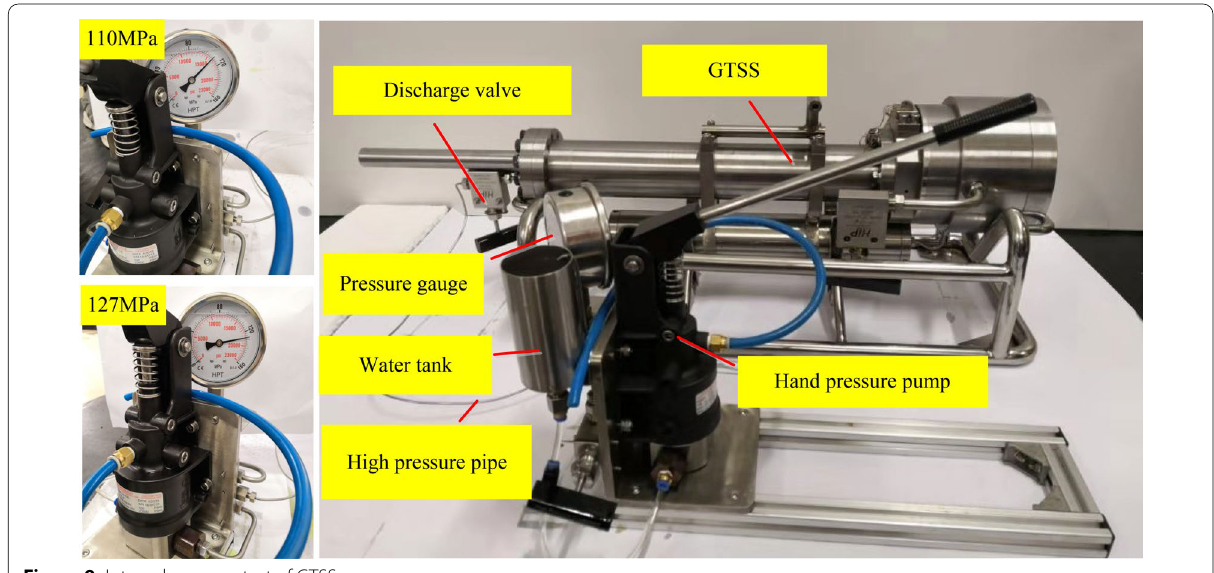
Figure 9 Internal pressure test of GTSS